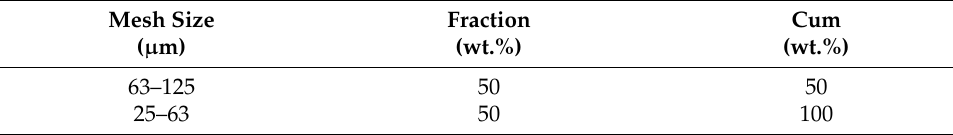
Table 4. The grain size distribution of Carajas iron ore.